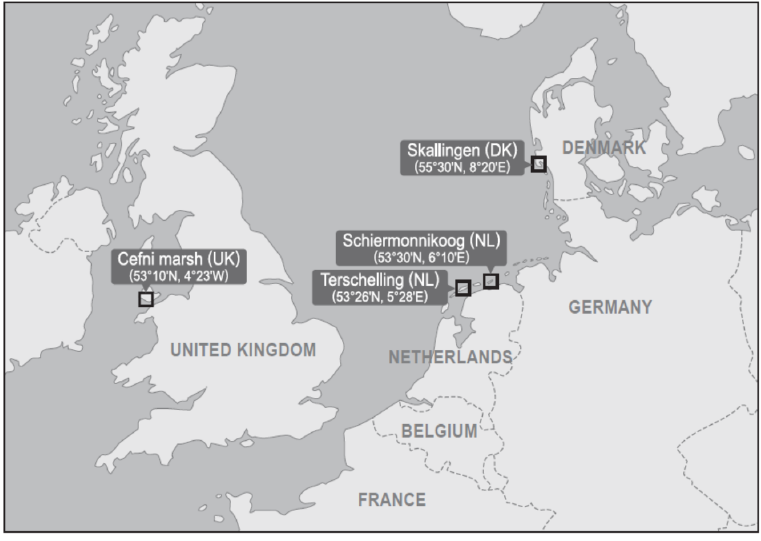
Figure 1. Field sites included in this study.